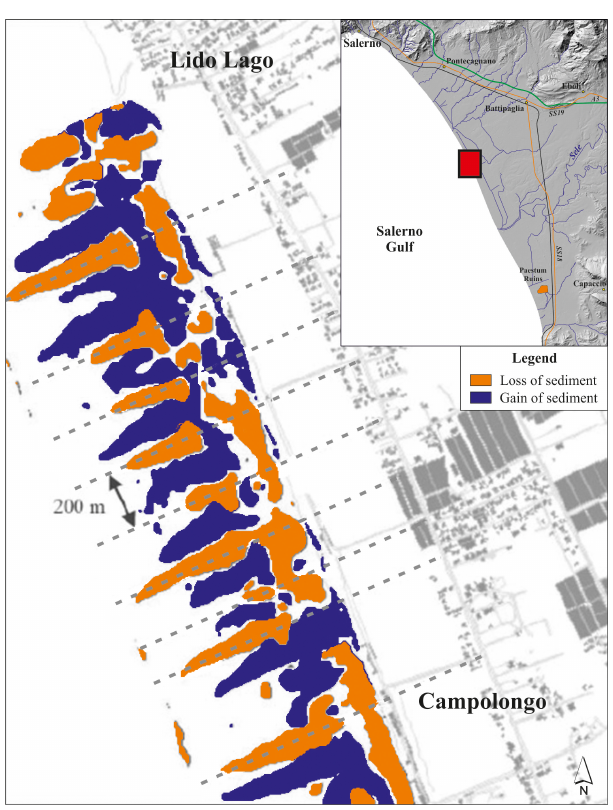
Figure 3. Loss and gain of sediment volumes in the north of the Sele mouth (modified from Pennetta et al., 2011b). The dotted lines represent the rip channels identifying the most probable position of the rip